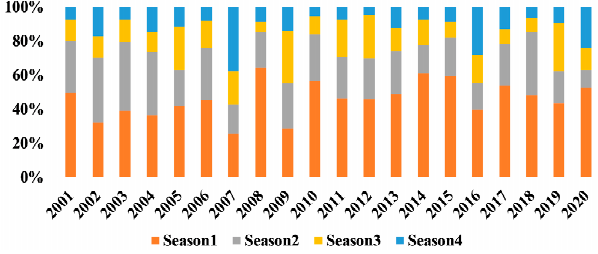
Figure 4. Seasonal distribution of wildfire annually.